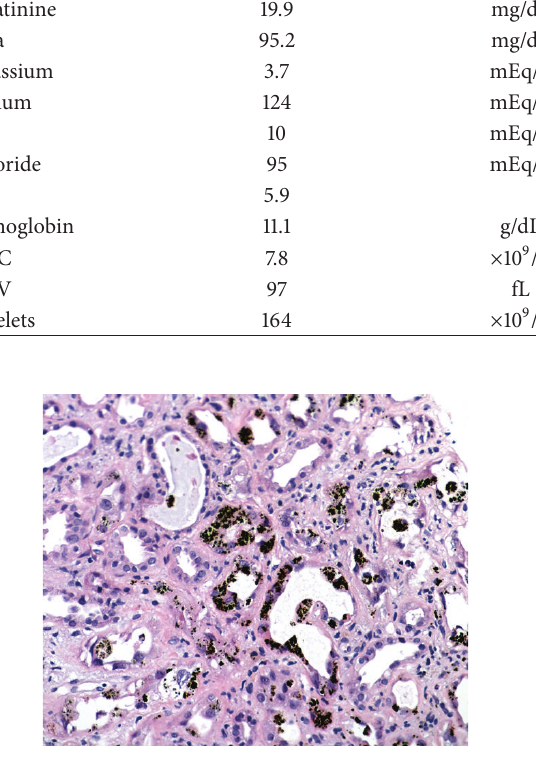
Figure 4: Electron microscopy shows segmental effacement of foot process with iron deposits (dark granules) (electron microscopy magnification ×